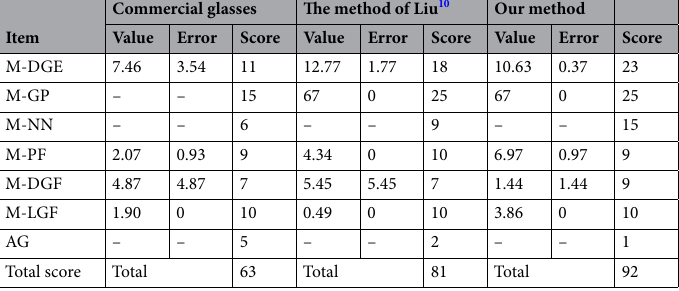
Table 5. GFS of example 1 with the commercial glasses, the Liu 10 method, and our